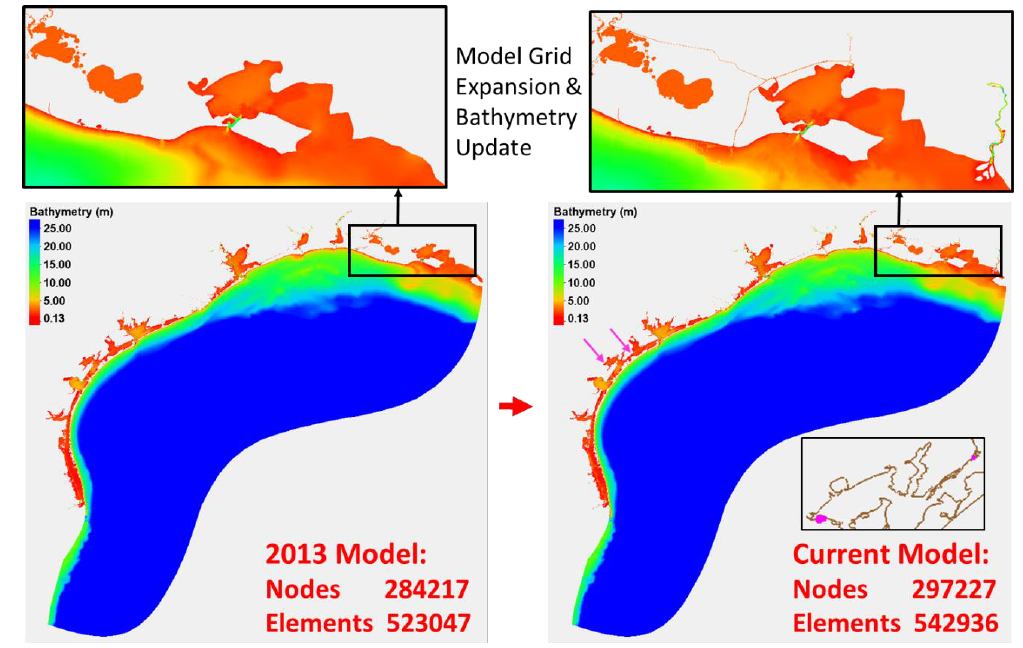
Figure 2. Model grid extension into smaller rivers and the Intracoastal Waterway (ICW) with updated bathymetry: before ( left ) and after ( right ) the model update. The two pink arrows in the right panel show the two areas with a minor extension of model grids in the middle of the TX coast. The extended model grid points in the two areas are shown as pink dots in the enlarged plot in the right lower corner of the right panel.